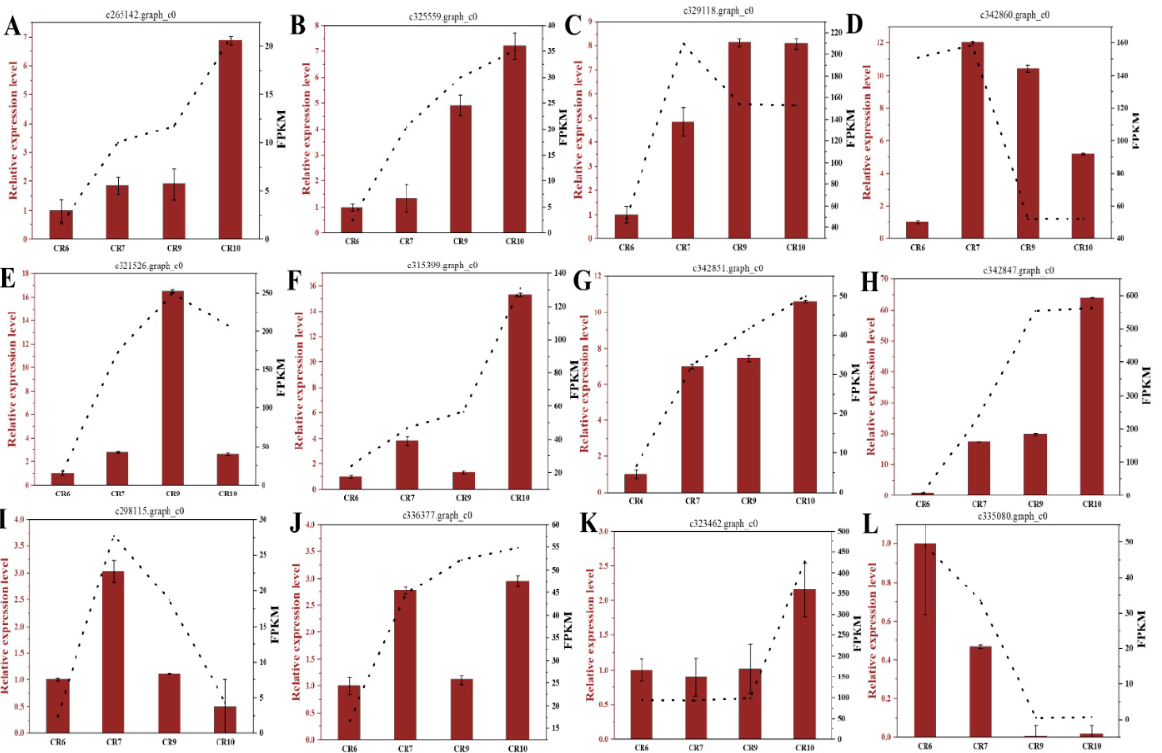
Figure 4. Verification of transcriptomic data by qRT-PCR analysis of 7 candidate gene expression patterns involved in sucrose transport and metabolism from CR6 to CR10 samples. ( A – L ) Expression of c265142 (SUC2-like), c325559 (SUT1), c329118 (SUT1), c321526 (SWEET1-like), c315399 (SWEET4), c342851 (SPS), c298115 (SUT3), c336377 (SPS), c323462 (SuSy), and c335080 (SUT1), respectively. The relative expression of target genes compared to a control gene (GAPDH, glyceraldehyde-3-phosphate dehydrogenase) was performed in triplicate with standard errors shown. qPCR values and fragments per kilo base per million mapped reads (FPKM) values from the RNA-seq experiment are shown as bars and lines, respectively.